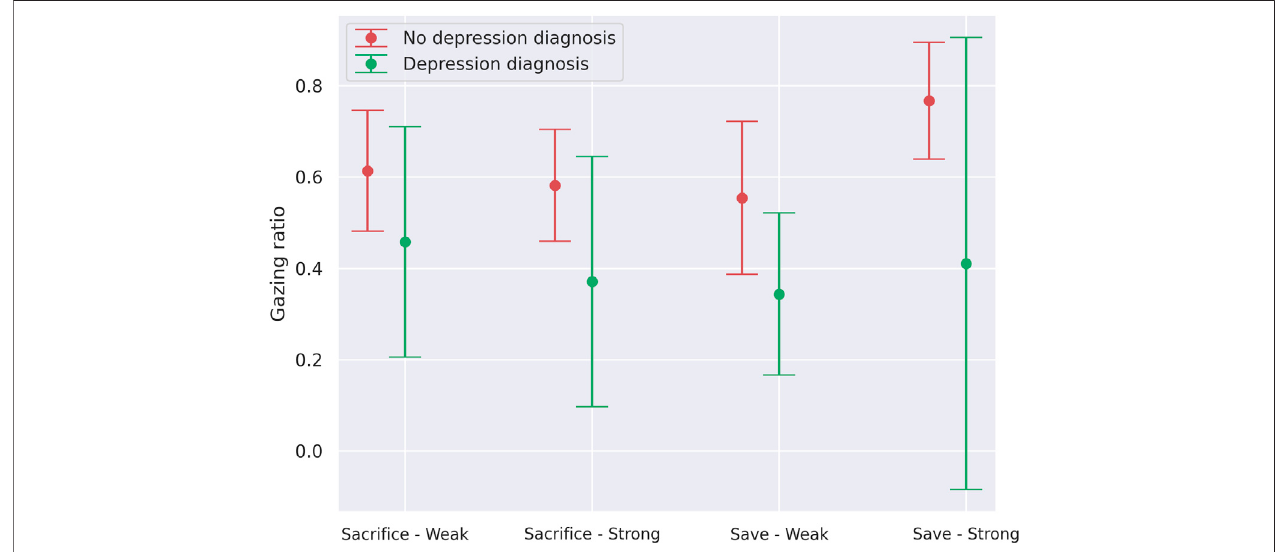
FIGURE 4 | Mean SC response rates and 95% con fi dence intervals during responsive utterances in respect to whether they were agreeing or disagreeing, and to save or sacri fi ce. Both saving and agreeing had a negative effect in respect to SC response rate.